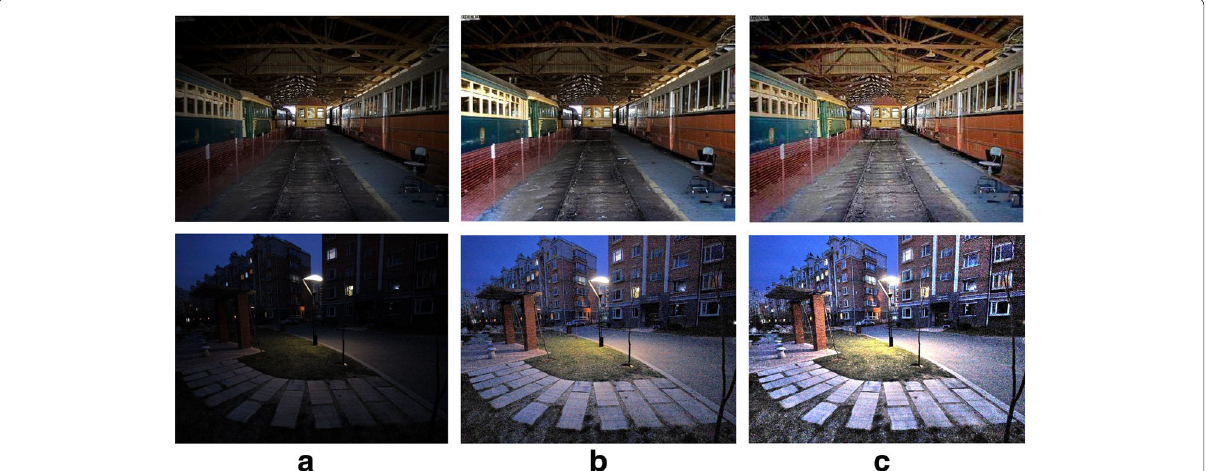
Fig. 9 Comparison of the proposed method with bright channel prior-based method [21]. a Input images. b Enhanced images with bright channel prior-based method [21]. c enhanced image with the proposed method